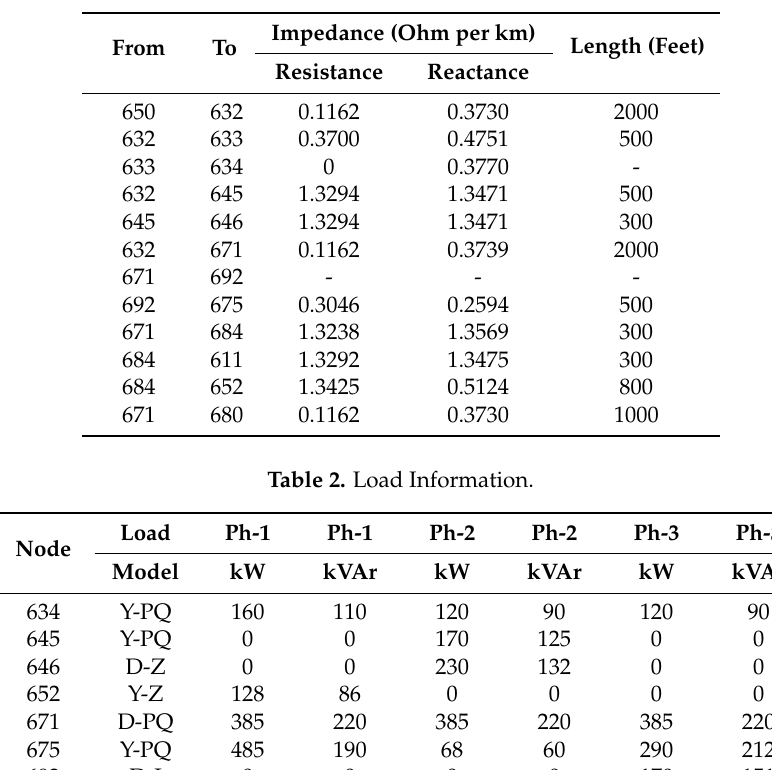
Figure 10. Microgrid system model built in Matlab/Simulink.